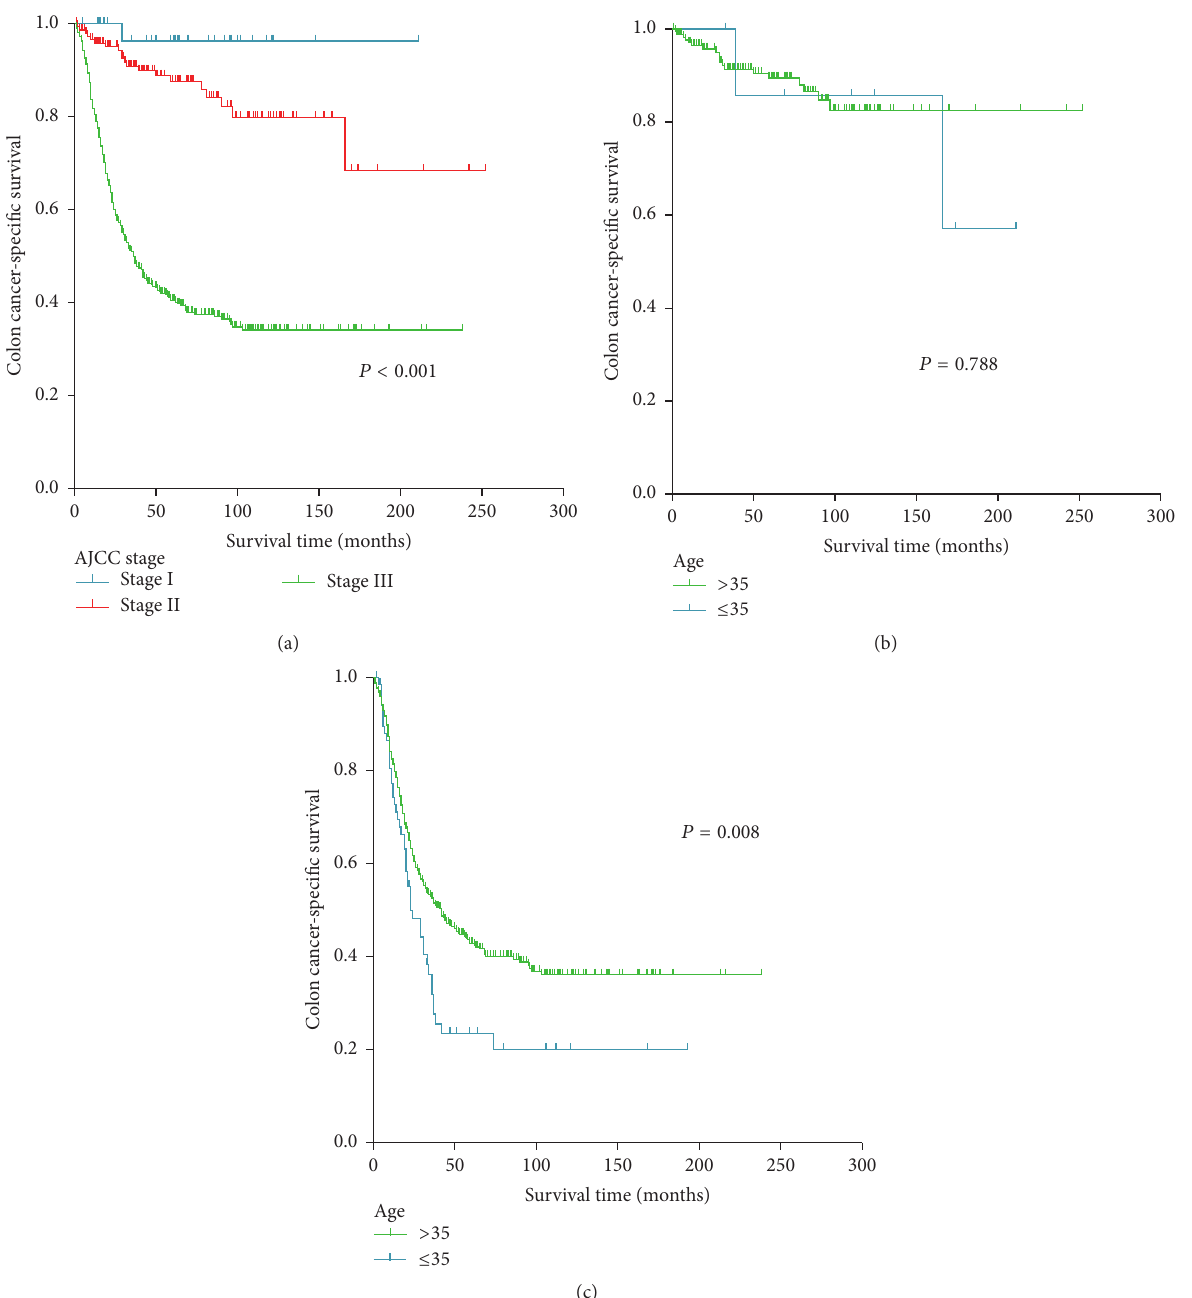
Figure 3: (a) Kaplan-Meier curves for patients with nonmetastatic SRCC of the colon stratified by TNM stage. Kaplan-Meier curves for patients with (b) stage I/II and (c) stage III SRCC of the colon stratified by age at diagnosis ( ≤ 35 or > 35